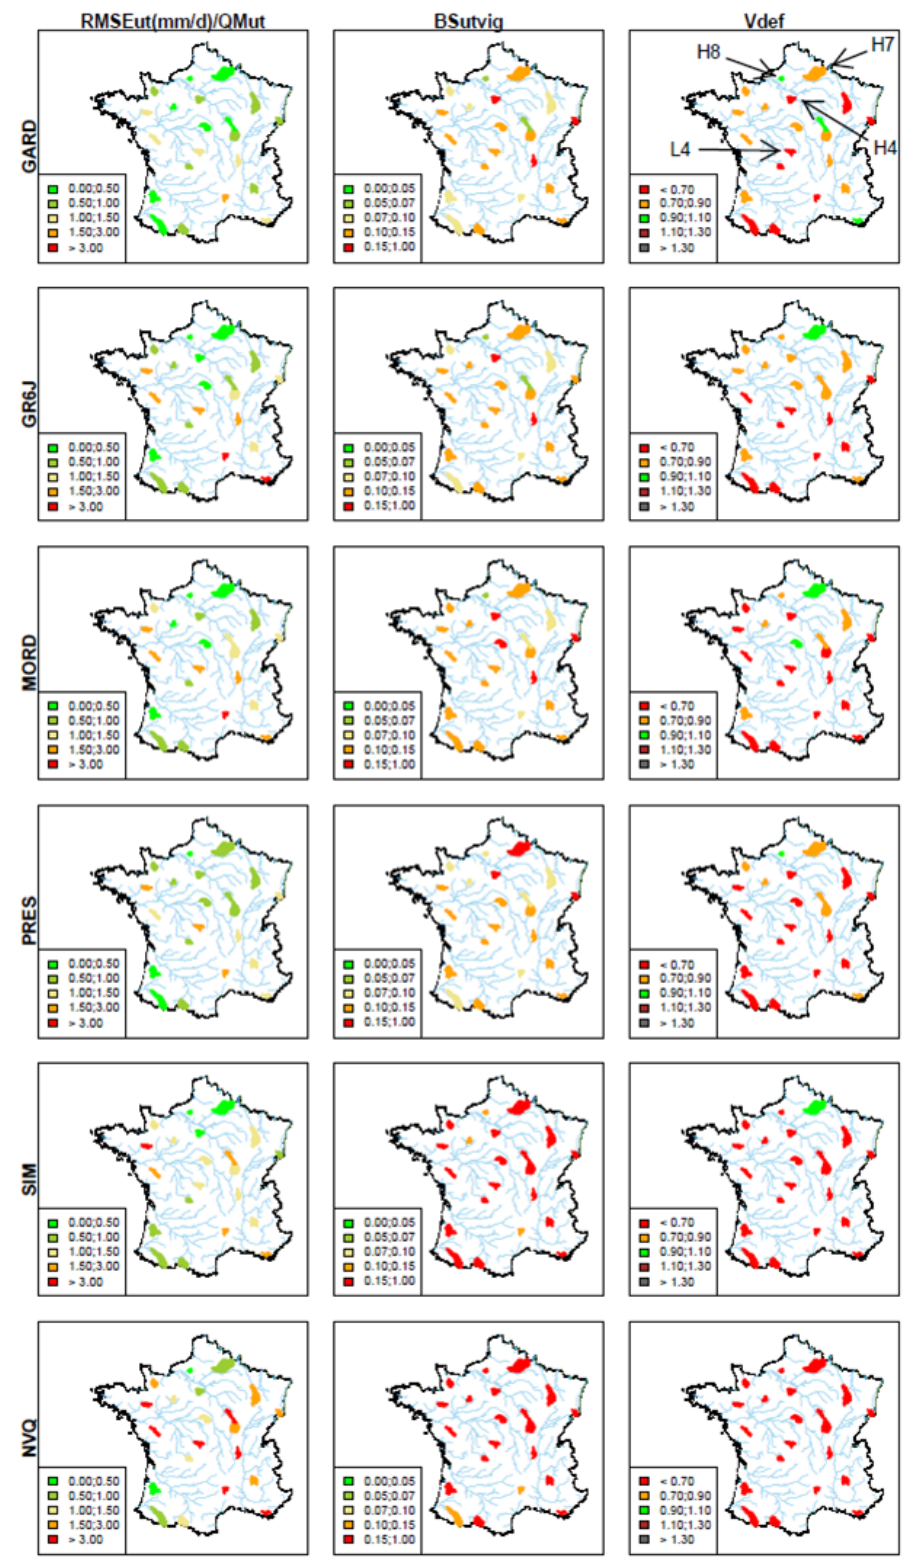
Figure 10. Model performance in forecasting mode on validation period 2 for the RMSE ut , BS vig and Vdef criteria for each model on the 21 catchments for a 7 day forecasting lead time. The letters on the top right map show the catchments (fist two letters of the HYDRO code, see Table 1) whose results are commented in more details in the text (H4: Orge; H7: Oise; H8: Andelle; L4: Petite